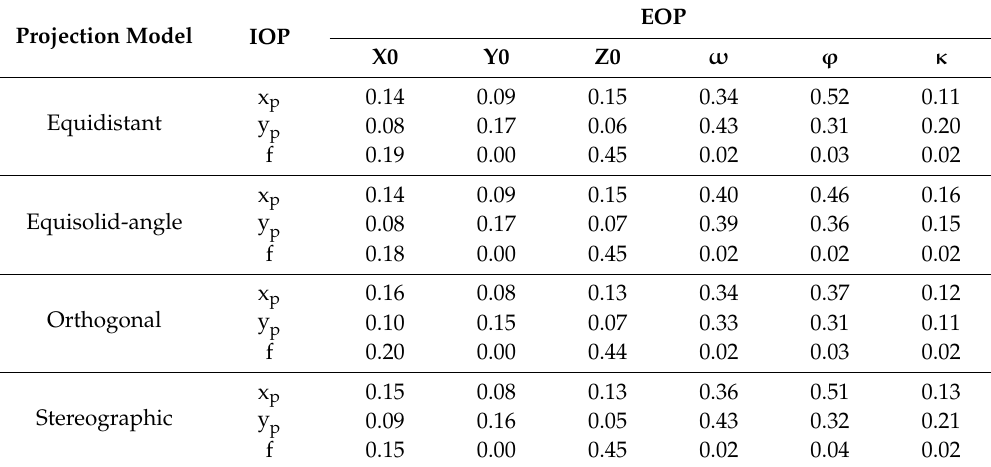
Table 19. Correlation between the orientation parameters (image-set 3).